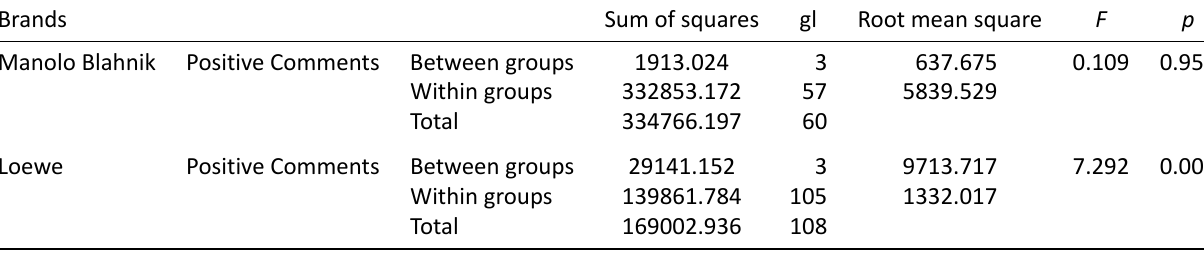
Table 5. ANOVA statistic of positive comments as a function of brand content.